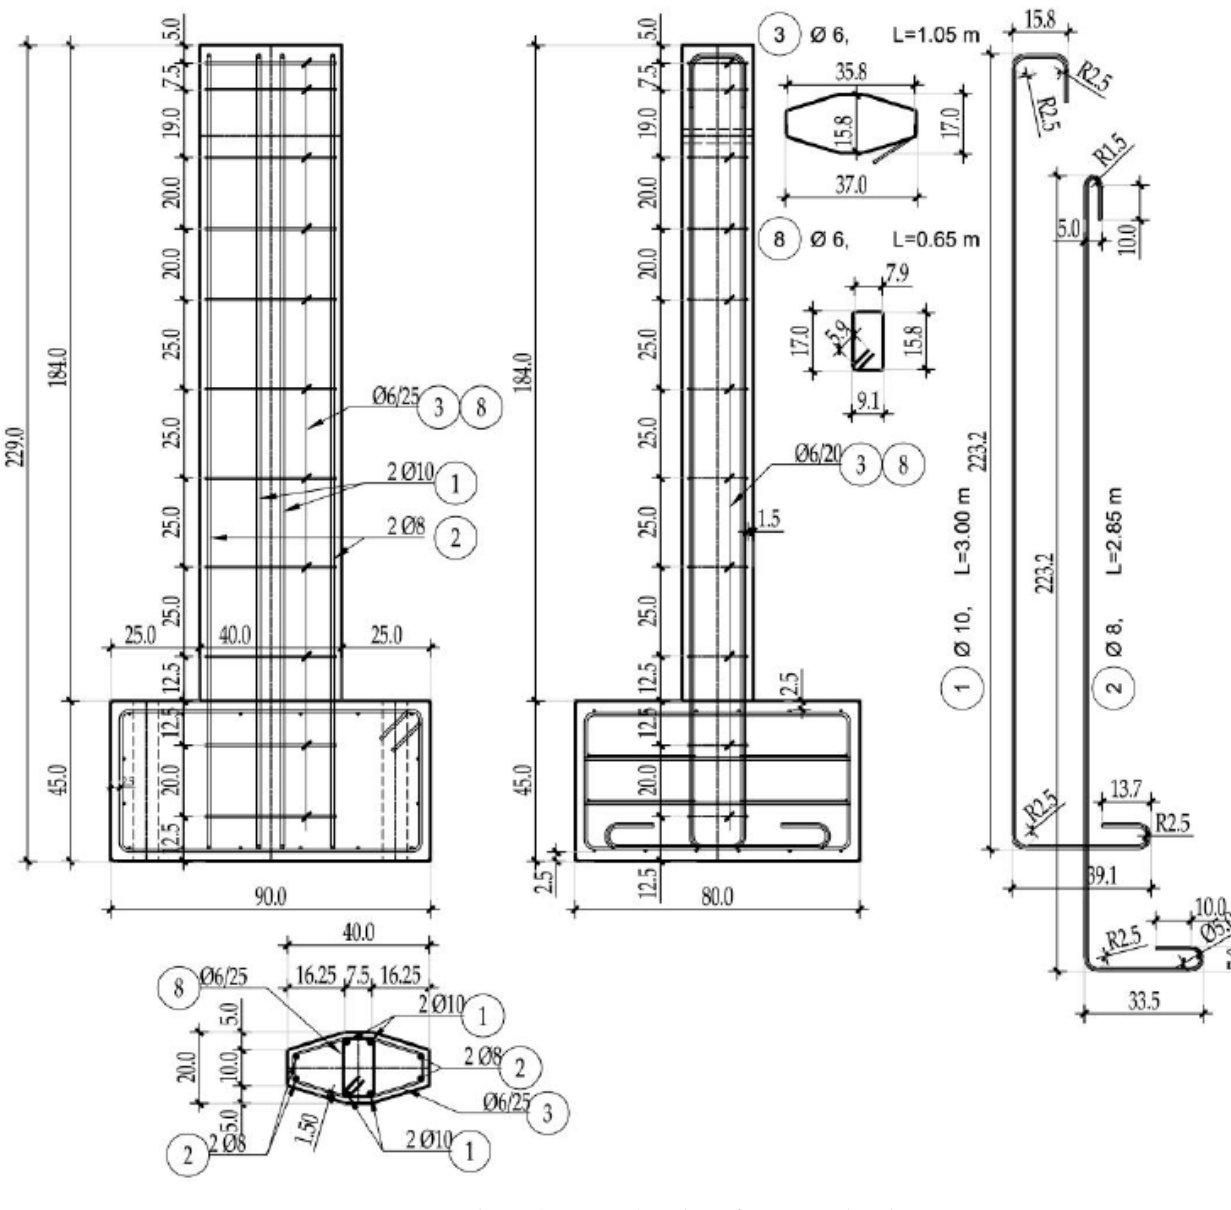
Figure 2. Column (series 001) and reinforcement details.